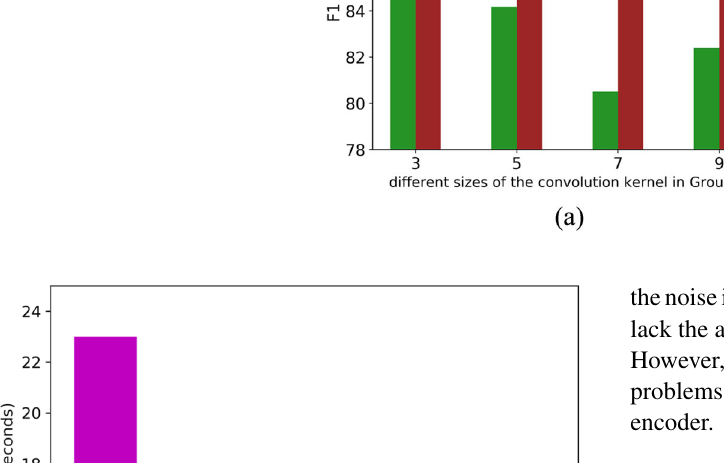
Fig. 15 F1 w.r.t different sizes of the convolution kernel in Group 1 and Group 2. a Reports the results in Group 1, b reports the results in Group 2